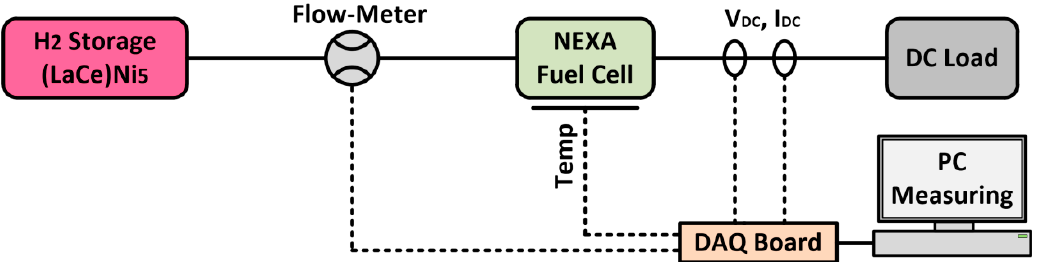
Figure 4. Diagram of the PEMFC heating distribution measurement.